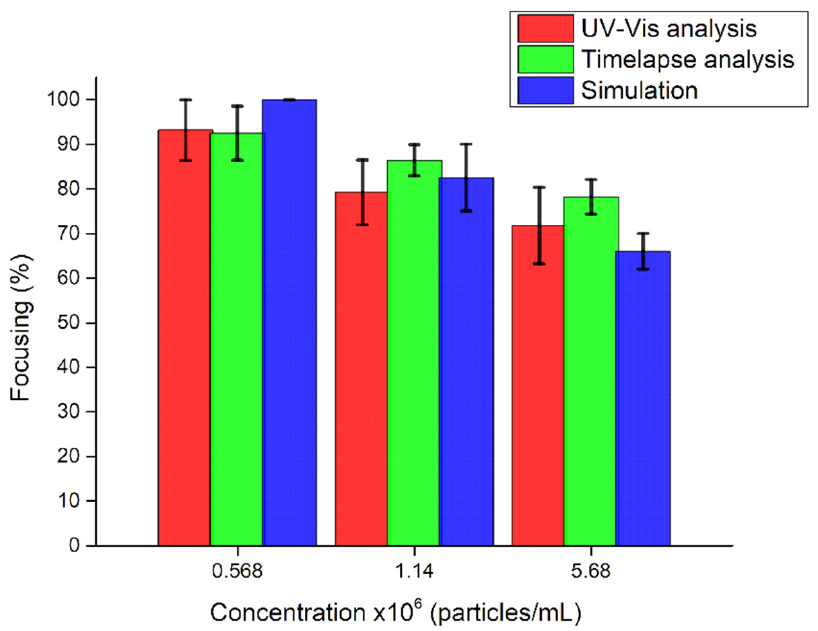
Figure 10. Comparison of the focusing performance of the BAW device obtained through simulations and experiments when 4MPs at different concentrations (5.68 × 10 6 particles/mL, 1.14 × 10 6 particles/mL and 5.68 × 10 5 particles/mL) are investigated. Experimental values are reported, characterized either by UV–Vis analysis or image analysis.